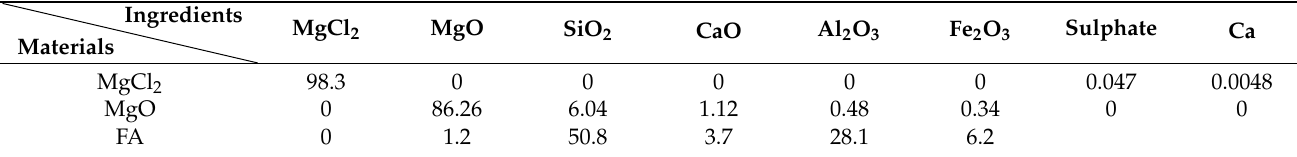
Table 1. Ingredient list of main materials